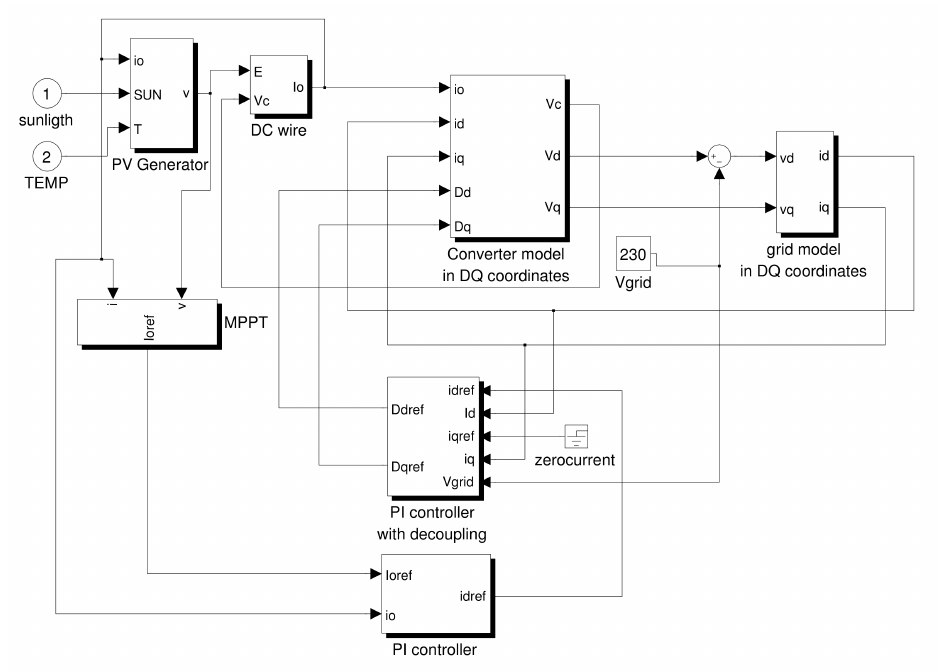
Figure 3. Block scheme of the control